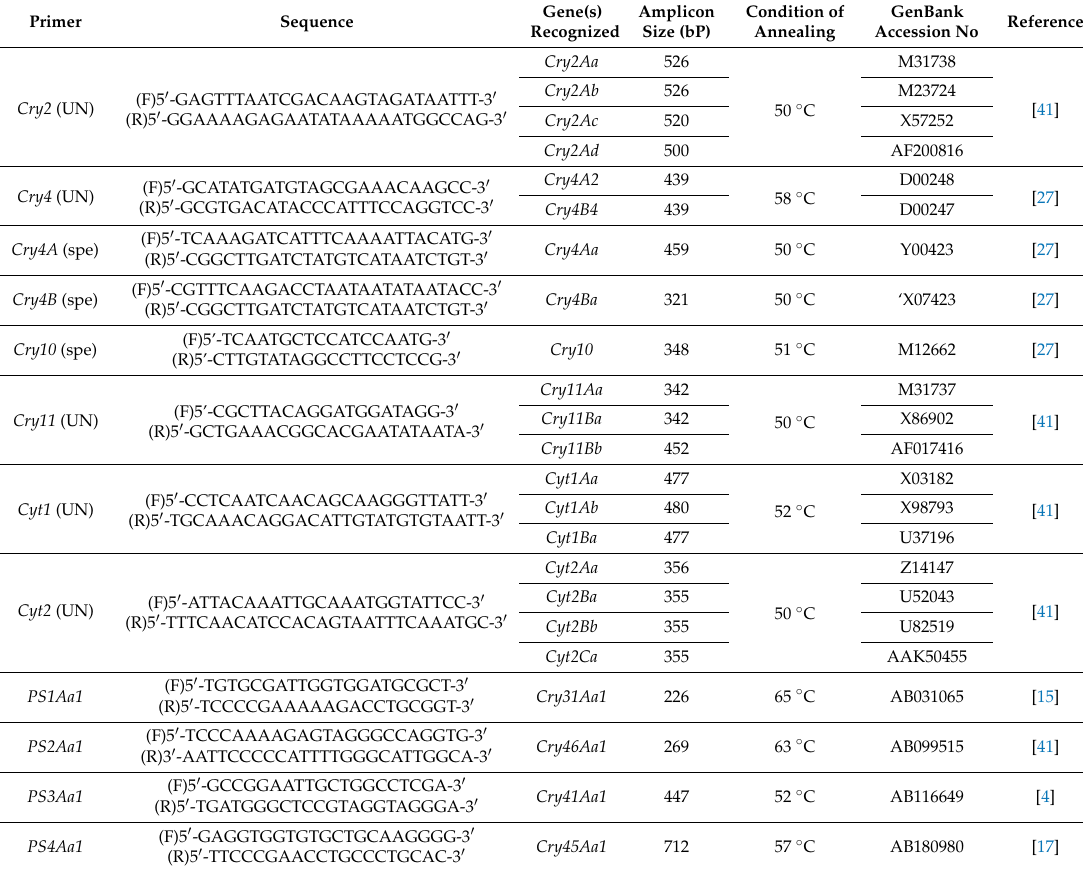
Table 3. Characteristics of general and specific primers employed for the detection of Cry , Cyt and PS genes. Primer Sequence